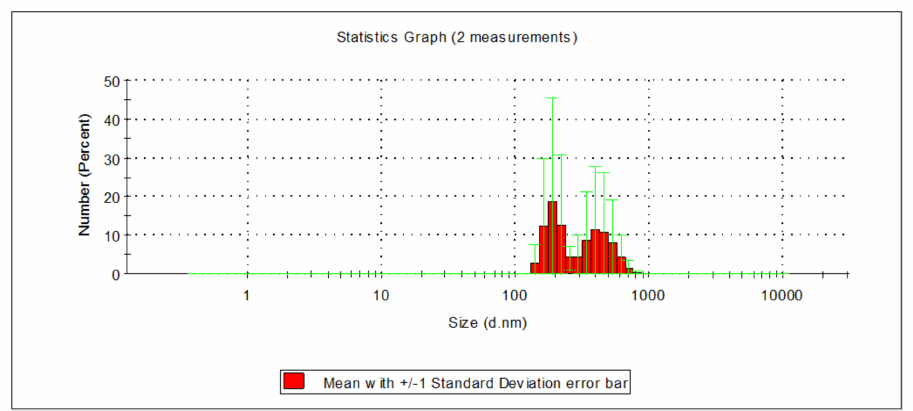
Figure 7. Distribution of particle sizes in water after the filtration process on a catalytic-oxidative sand filter